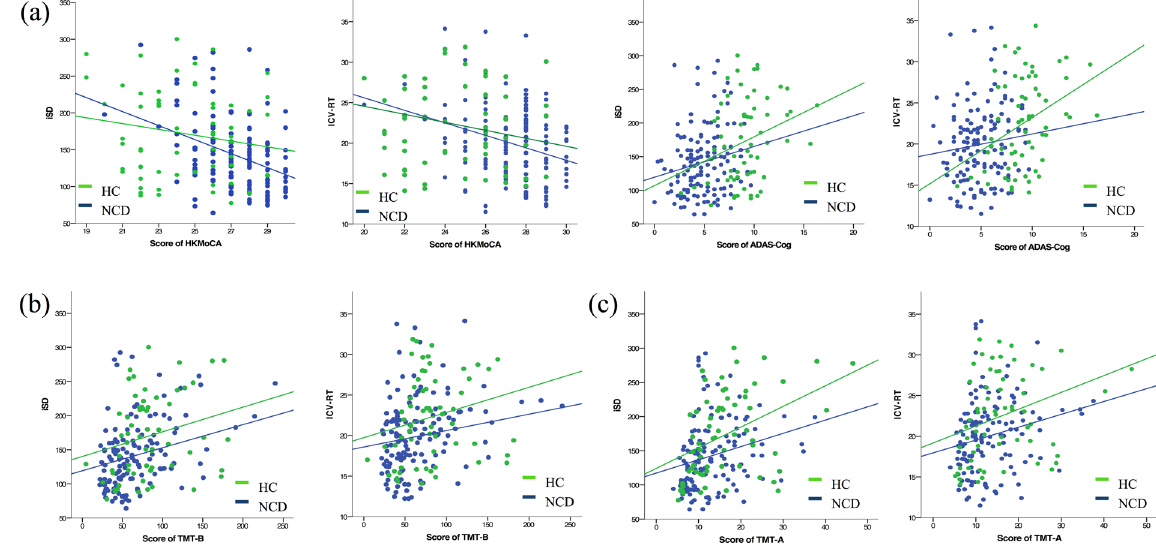
Figure 3. Correlations between RT measures and neurocognitive function. Elevated intra-individual variability of RT was associated with the worse performance of global cognition ( a ), executive function ( b ), and attention ( c